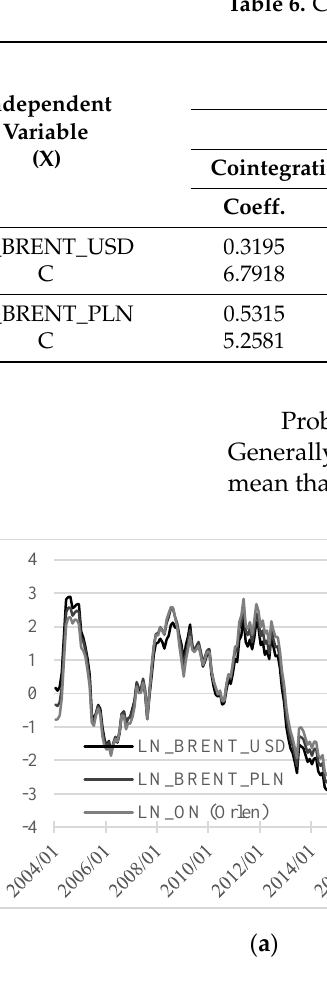
Figure 2. Residuals from cointegrating models: ( a ) CPI_Y/Y; ( b ) CPI_01.2004 = 100.